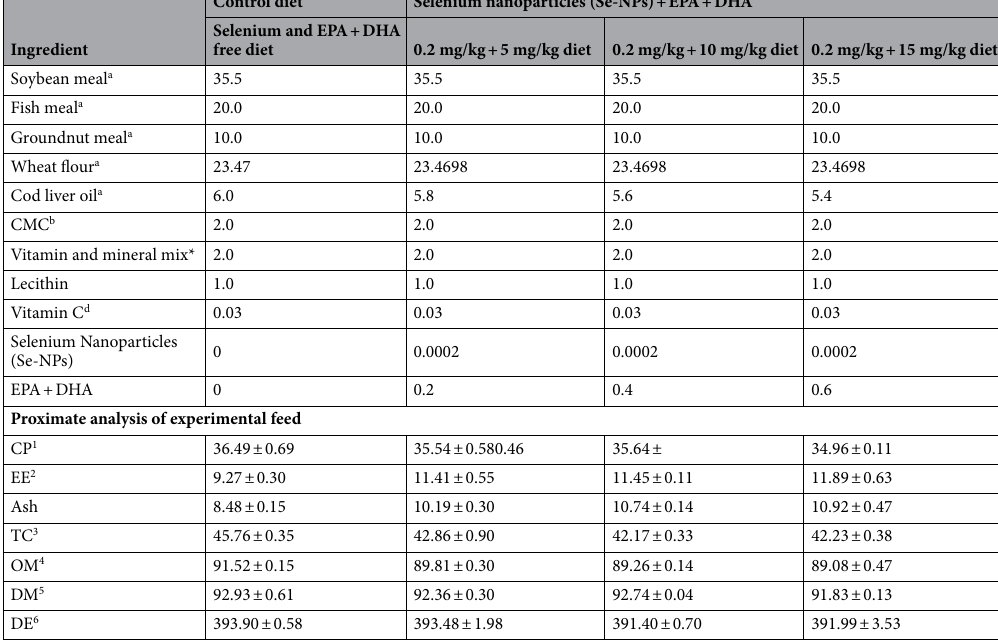
Treatments details Symbols